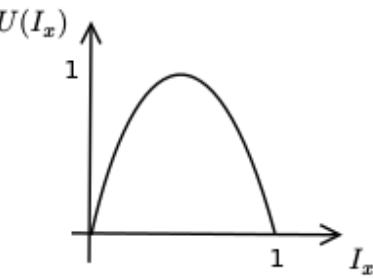
Figure 8. Adopted utility function for any Lacanian